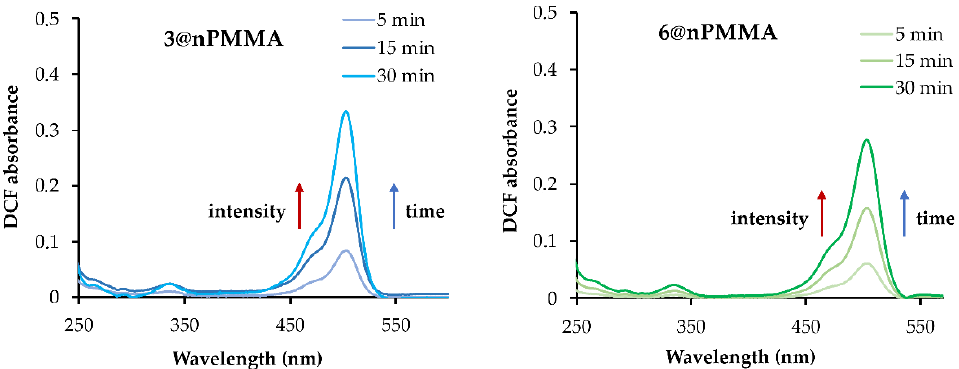
Figure 3. ROS production of 3@nPMMA and 6@nPMMA nanoparticles displayed as absorption spectra of DCF measured at different irradiation times (minutes).